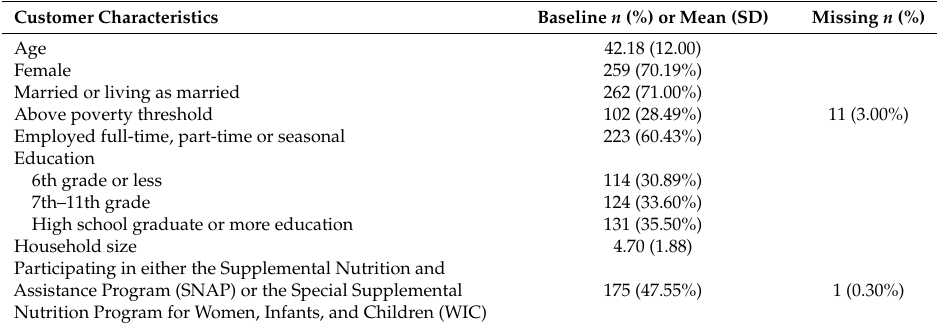
Table 1. “ El Valor de Nuestra Salud ” (The value of our health) customer characteristics ( n =